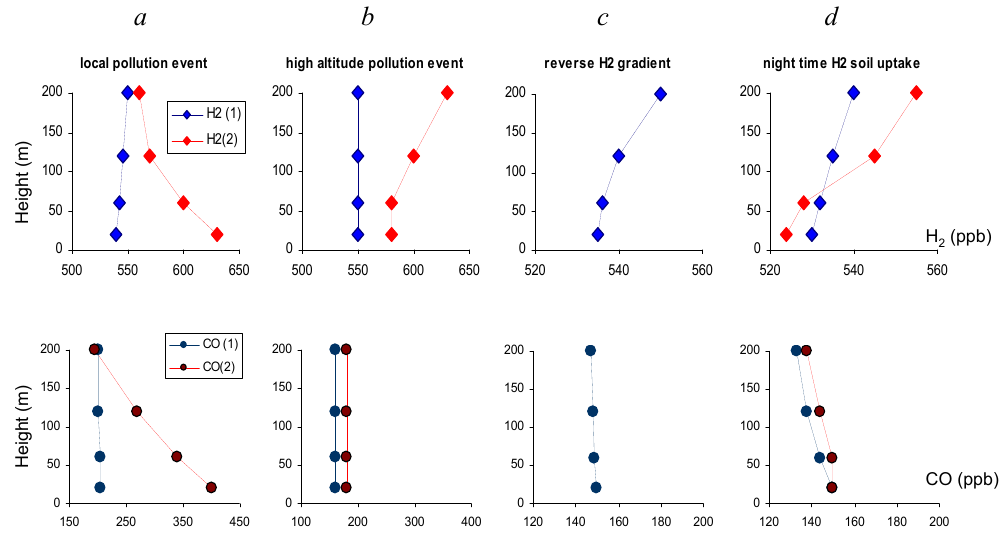
Fig. 6. Vertical profiles of H 2 (top) and CO (bottom) for various atmospheric situations. Except for plots (c) , vertical profiles before (blue) and during the event (red) are shown (see text for explanations). Note that the x-axis ranges are not the same for all plots, but the proportion between H 2 and CO ranges is maintained. (a) Local pollution event (night of 18–19 March 2009, see also Fig. 5a). (b) Pollution event at the highest sampling altitude (22 February 2008, see also Fig. 5c). (c) H 2 reverse gradient (27 March 2009, see also Fig. 5e). (d) Night time soil uptake of H 2 (21 May 2009, see also Fig.